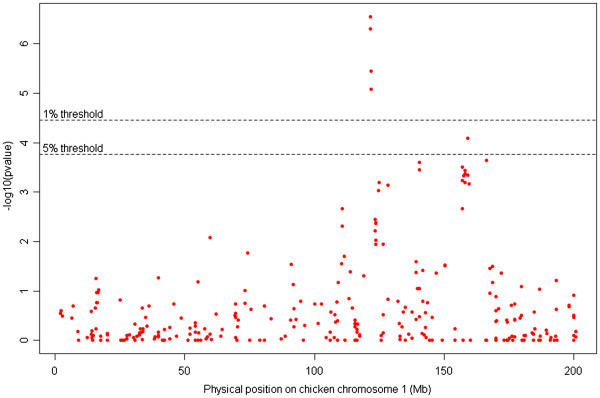
-log10(p_value) plot of the association study of tonic immobility in the AIL_DD population. Each SNP is mapped to its orthologous position on chicken chromosome 1.